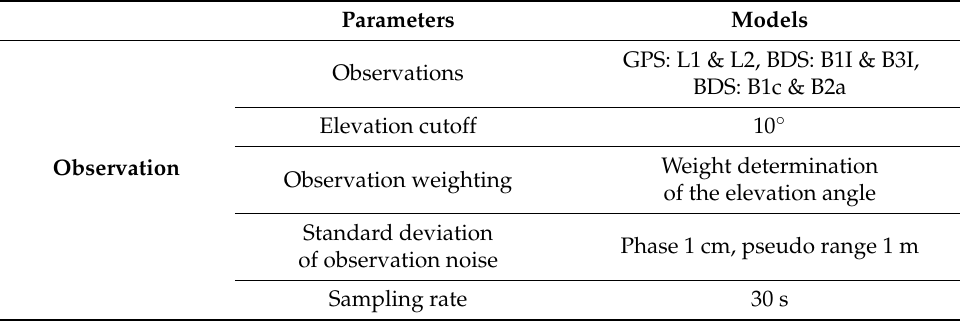
Table 1. Precise point positioning configuration